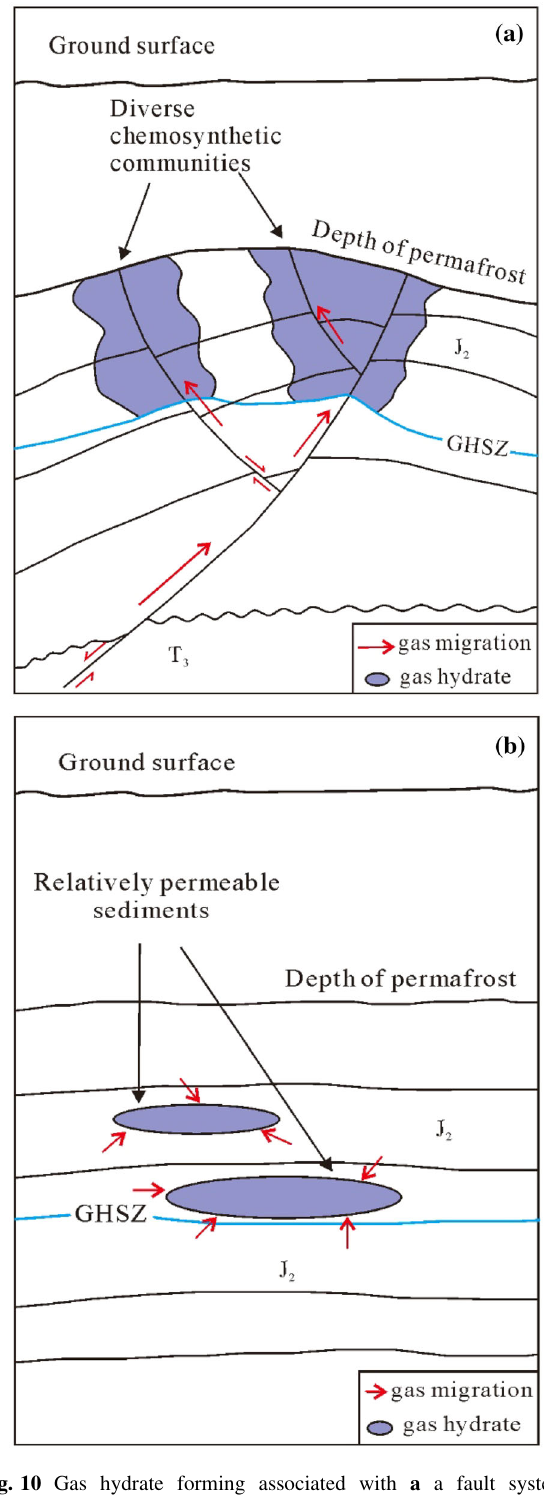
Fig. 10 Gas hydrate forming associated with a a fault system; b